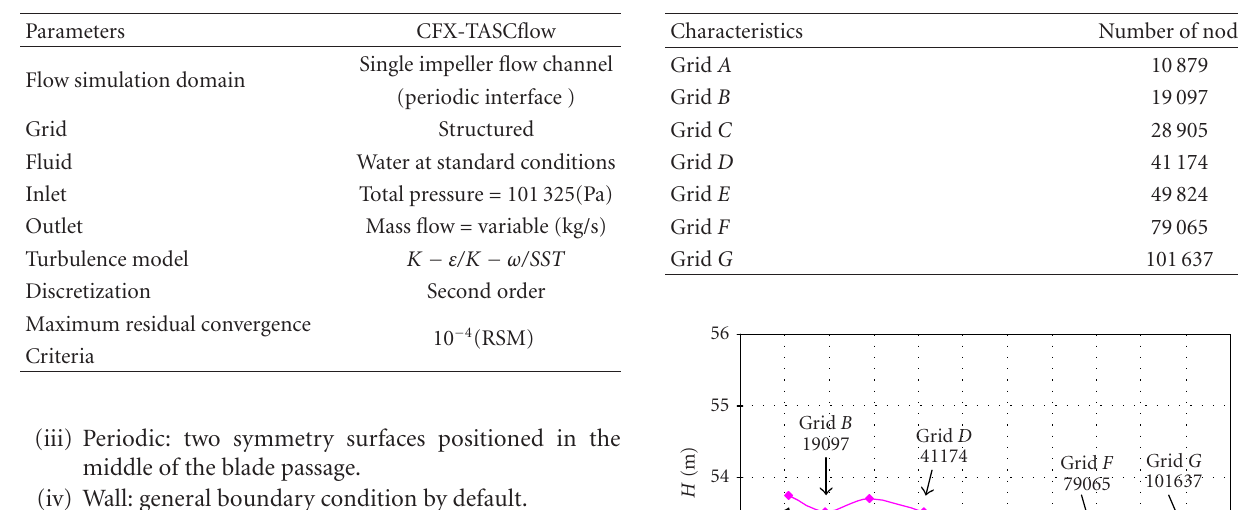
Table 2: Impeller NS32: simulation parameters. Table 3: Evaluated grid sizes.